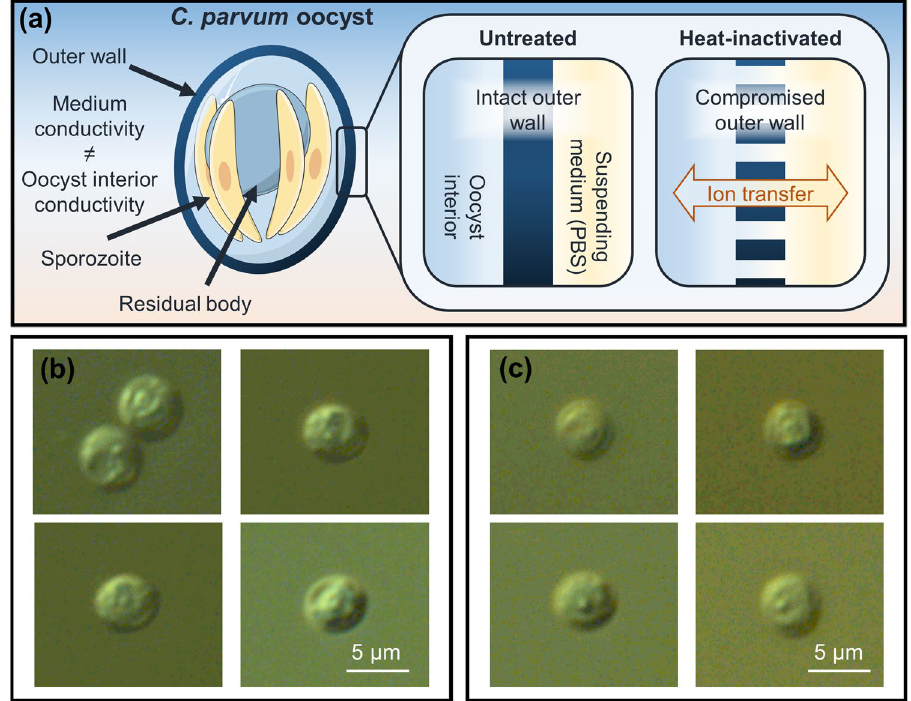
Figure 3. Diagram showing the structure of both the untreated (live) and heat-inactivated (non-viable) C. parvum oocysts. ( a ) Schematic showing hypothetical effect of heat-inactivation on oocysts suspended in PBS. The C. parvum oocyst generally consists of a trilaminar outer wall, which contains four naked, sporozoites and a membrane-enclosed residual body. Upon inactivation, the direction of ion transfer is influenced by buffer conductivity/osmolality. ( b ) Microscope images of untreated and ( c ) heat-inactivated oocysts (in PBS), viewed with oil immersion (100x) DIC